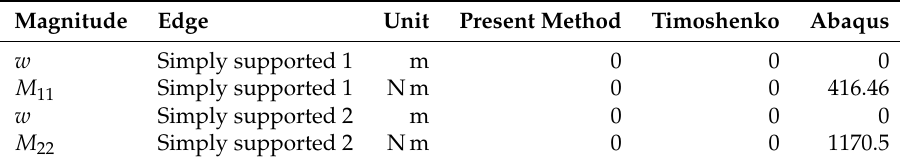
Table 4. Compliance with boundary conditions at the midpoints of the